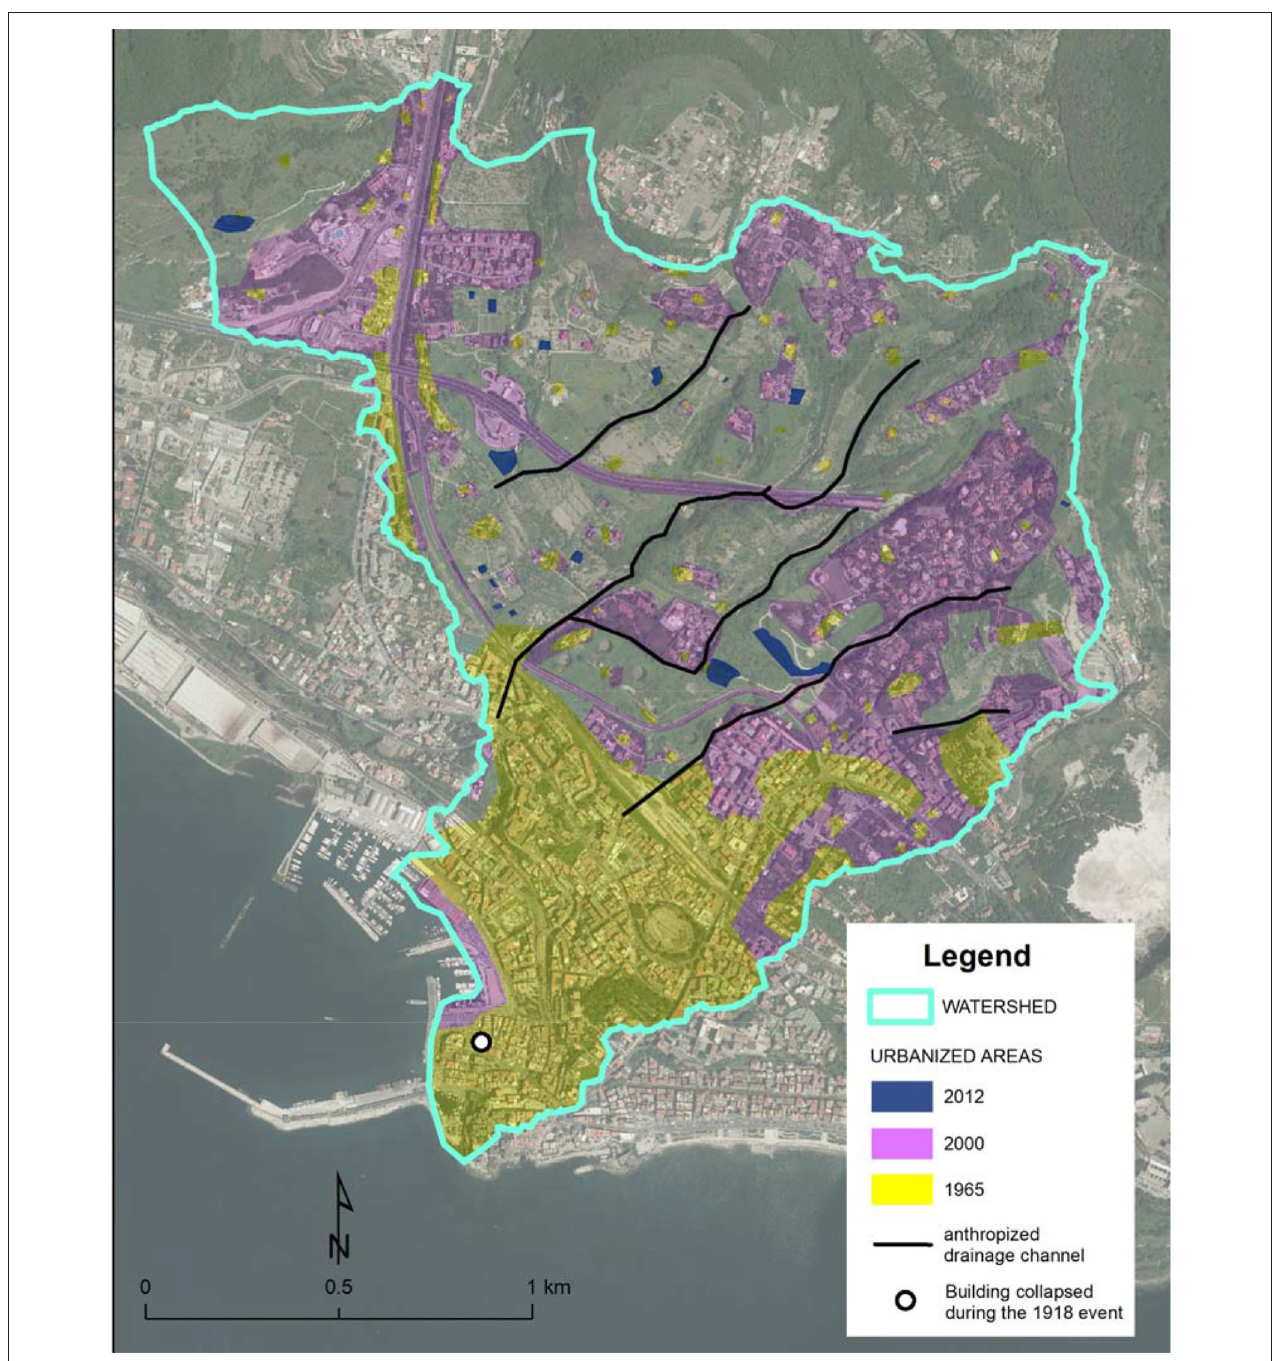
FIGURE 11 | Map showing the urban expansion of the Pozzuoli town in the years 1965, 2000, and 2012.